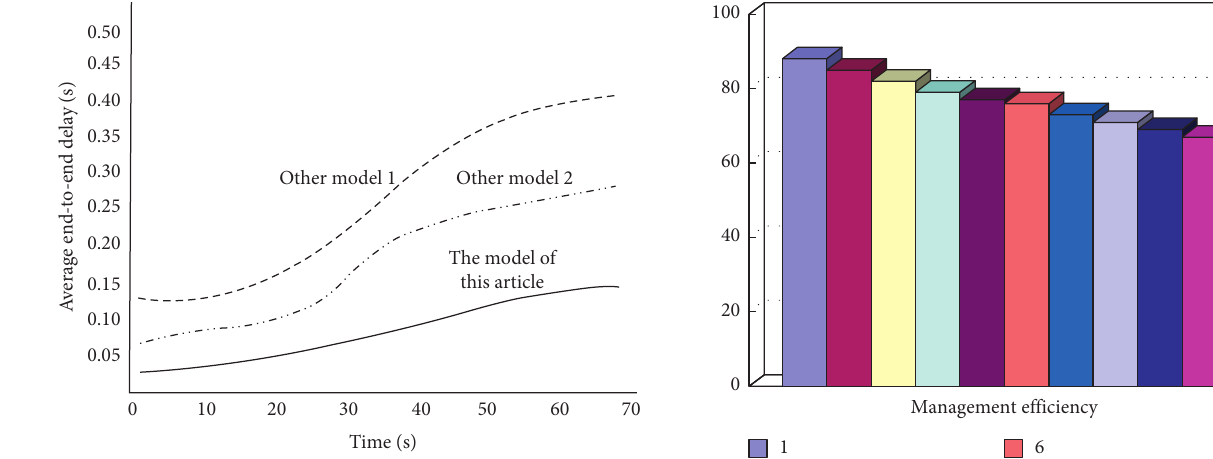
Figure 3: Comparison of average end-to-end delay of different models.